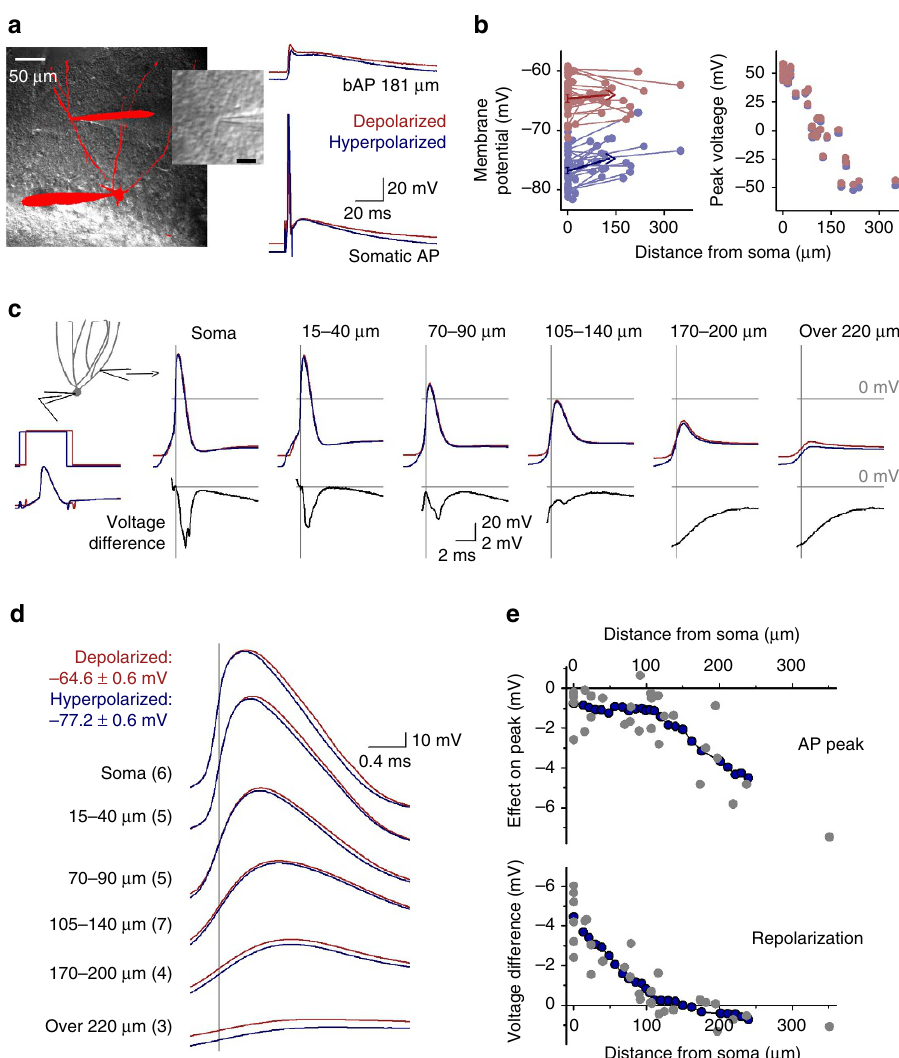
Figure 1 | Location-dependent effects of somatic membrane potential on bAP waveforms. ( a ) Superimposed IR-DIC and confocal z stack images of a GC, which was simultaneously recorded at a somatic and a dendritic site. Spikes were evoked with short current injections at the soma and the membrane potential was also set at this location with steady-state current injections to slightly depolarized (red, (cid:2) 64.6 ± 0.6mV, n ¼ 29) or hyperpolarized (blue, (cid:2) 77.2 ± 0.6mV) potentials. The second pipette was used for monitoring the undisturbed voltage either at a dendrite or at the soma. ( b ) Propagation of somatically set membrane potential into dendrites (left panel). Connected symbols indicate individual experiments. Arrows show the average vector of the membrane potential difference. The right panel shows the distance dependence of the absolute bAP peak voltage (see also ref. 26). ( c ) Average bAP waveforms at various monitored locations. Representative somatic traces are shown on the left. Spikes were aligned to their maximum rate of rise (vertical grey lines). Black traces below show the voltage difference between the bAPs evoked from hyperpolarized and depolarized potentials. ( d ) The same average bAPs as in c on different timescale. Numbers show the included experiment numbers. ( e ) Effects of hyperpolarization on the peak voltage and relative repolarization of bAPs. Grey symbols indicate individual experiments, whose running average is shown in blue (calculated from 9 neighboring data points). To quantify the differences during the repolarization relative to the loss of the peak voltage, the voltage difference between the two bAPs at 0.2–1.2ms after the peak was compared with the voltage difference at the